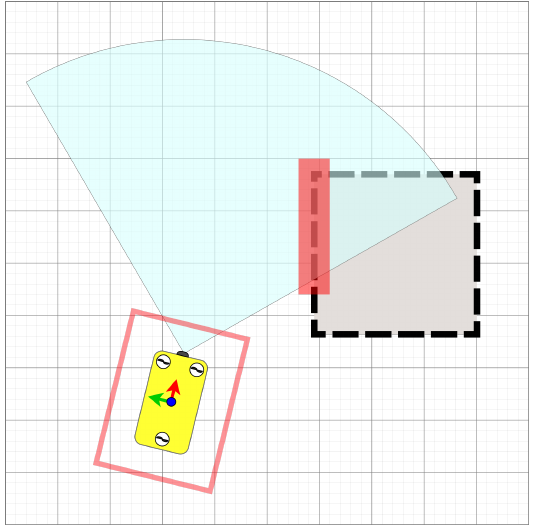
Figure 5. During operation, to compensate for errors in control and sensing, the approach inflates the sensed environment and/or the bounding box of the vehicle. The cells within the red box are added to the map used for collision